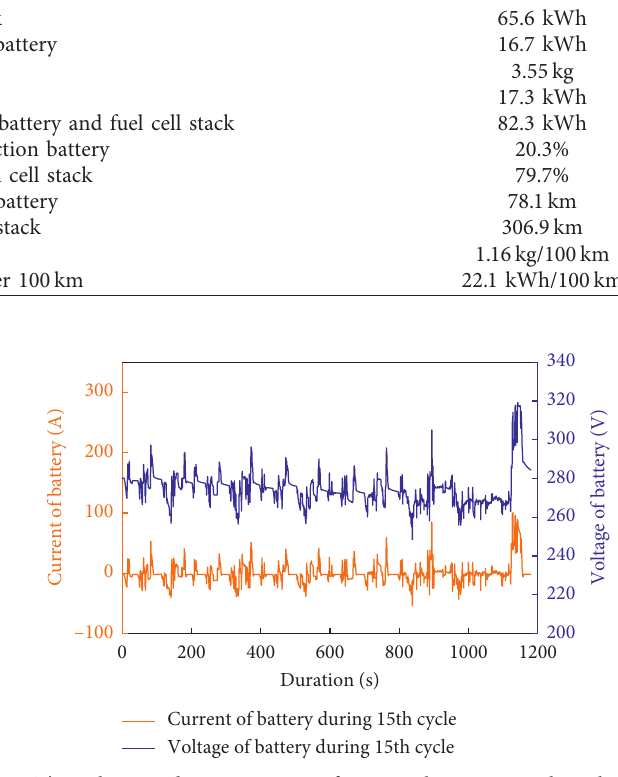
Figure 8: The voltage and current curve of traction battery in 20th cycle of the test. Table 3: The results of H 2 consumption and range of the nonplug-in FCV passenger